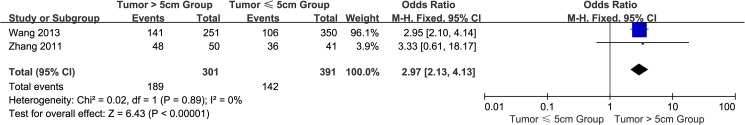
Meta-analysis of overexpression of EpCAM in tumour > 5cm group and tumour ≤5cm group.